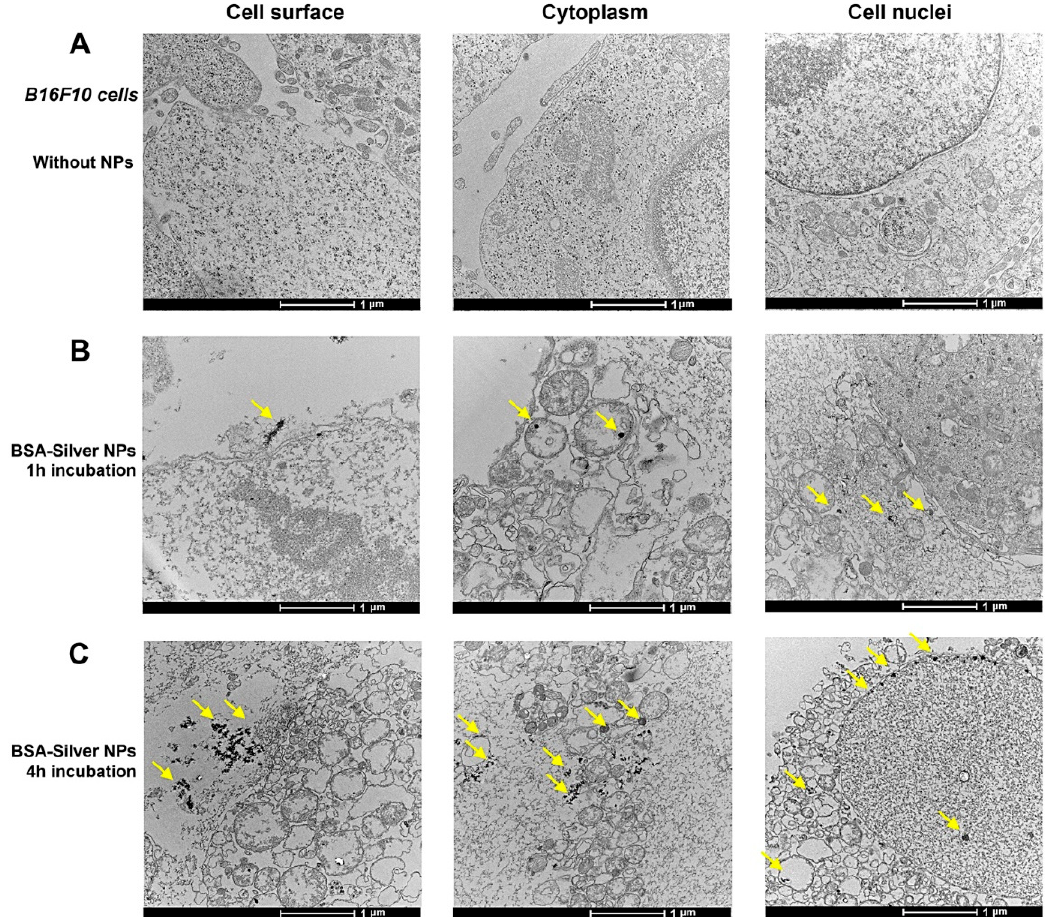
Figure 4. BIO − TEM examination of BSA − Silver NPs: ( A ) B16F10 cells without treatment; cells incu- Figure 4. BIO-TEM examination of BSA-Silver NPs: ( A ) B16F10 cells without treatment; cells incubated with BSA-Silver NPs bated with BSA − Silver NPs for ( B ) 1 h or ( C ) 4 h. BSA − Silver NPs are shown with the yellow ar- for ( B ) 1 h or ( C ) 4 h. BSA-Silver NPs are shown with the yellow arrows on the images. (BIO-TEM: biological transmission rows on the images. (BIO − TEM: biological transmission electron microscopy, BSA − Silver NP: electron microscopy, BSA-Silver NP: BSA-coated silver BSA − coated silver nanoparticles).